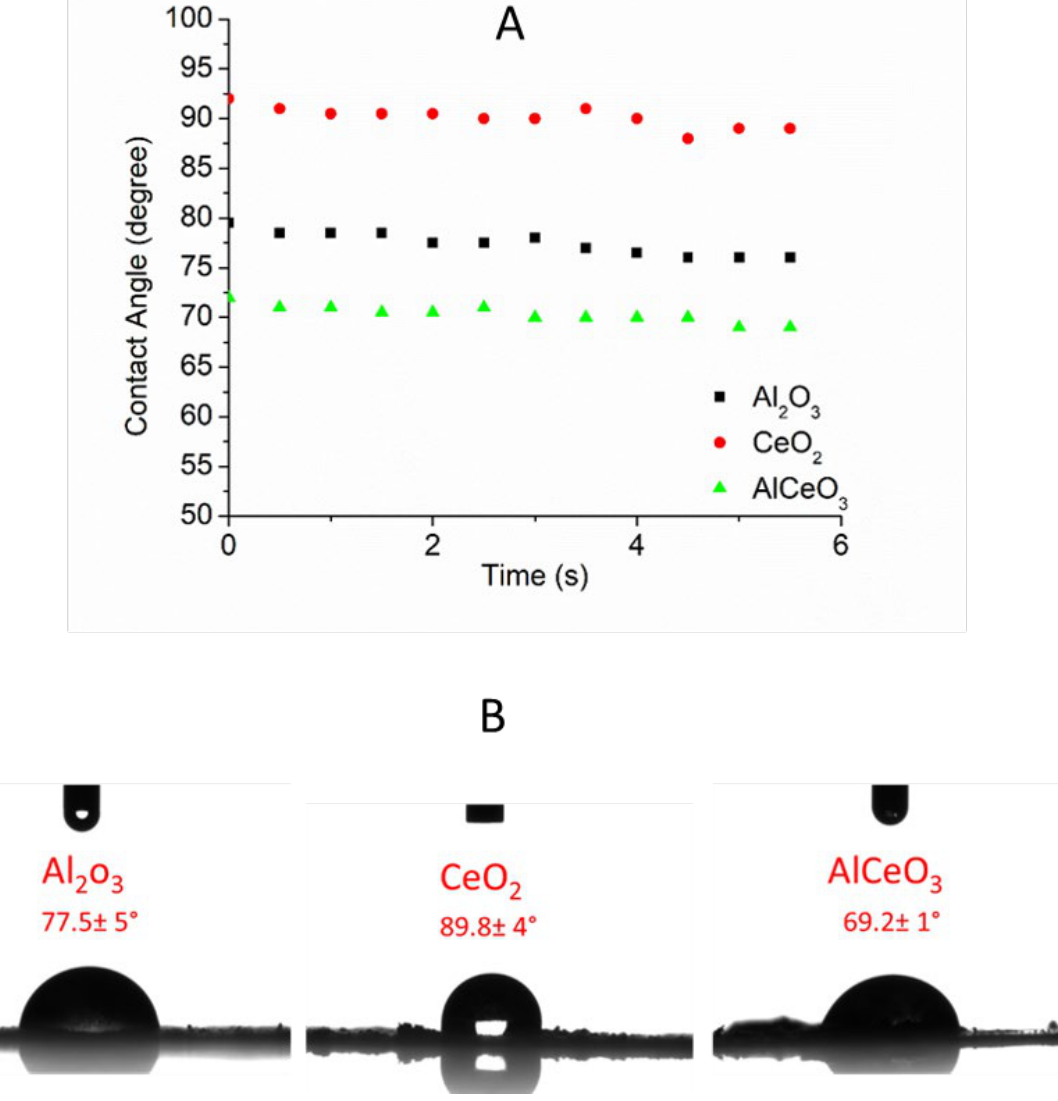
Figure 5. Contact angles of water droplets on Al 2 O 3 , CeO 2 , and AlCeO 3 nanopowders determined with the static sessile drop method during the first 6 s ( A ) and images of water droplets and Al 2 O 3 , CeO 2 , and AlCeO 3 nanopowders attached to a microscope glass slide with adhesive tape ( B ) .